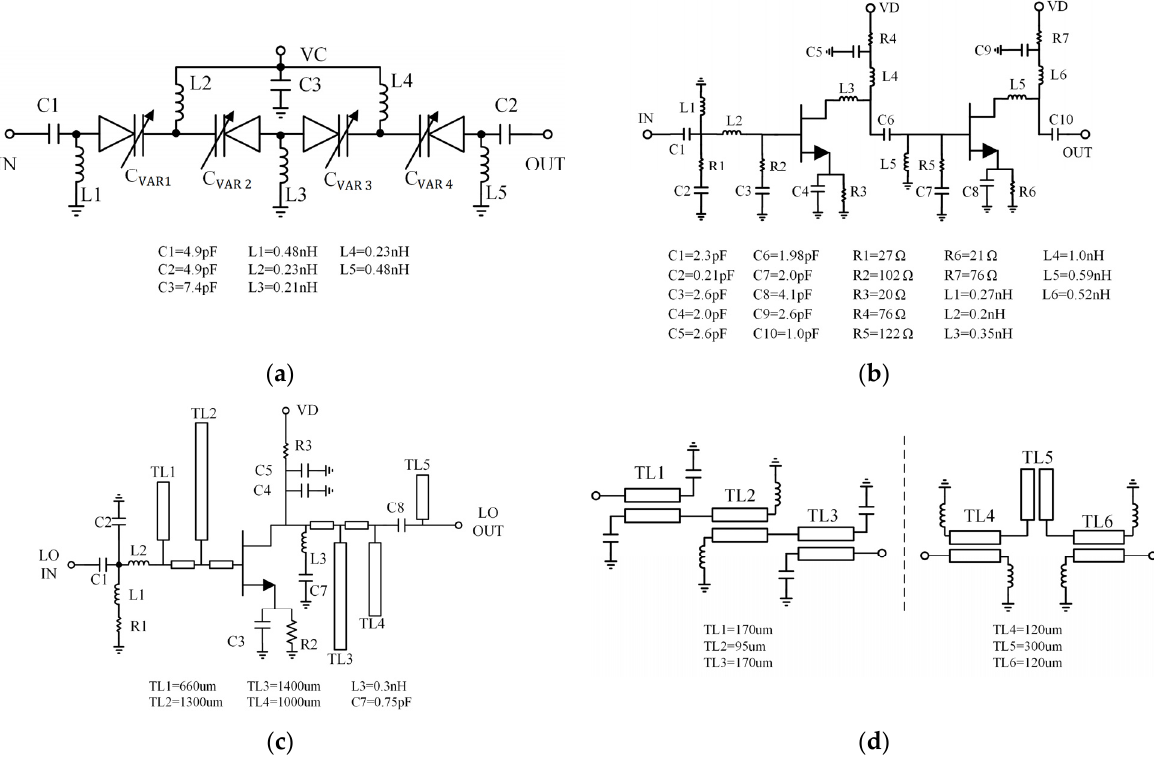
Figure 18. The schematic diagram. ( a ) Phase shifter. ( b ) 10 GHz amplifier. ( c ) Quadrupler. ( d ) BPFs.